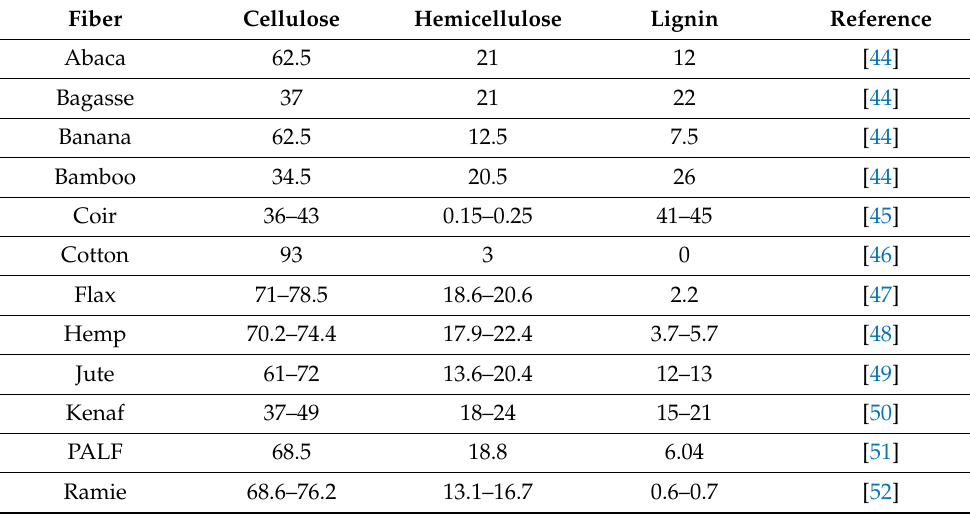
Table 1. Chemical composition (wt %) of some green